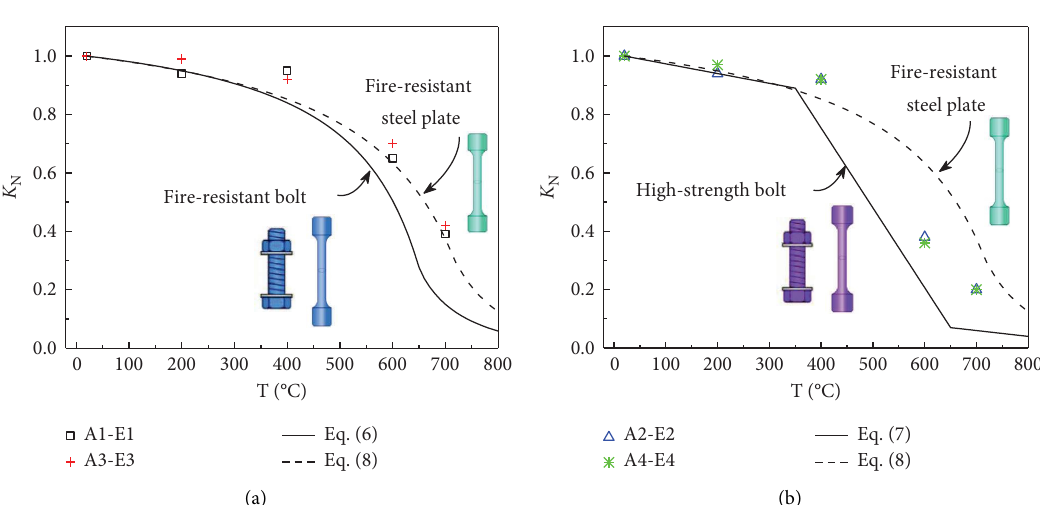
Figure 12: Comparison of material reduction factor and experimental results. (a) Specimens of fre-resistant high-strength bolts. (b) Specimens of ordinary high-strength